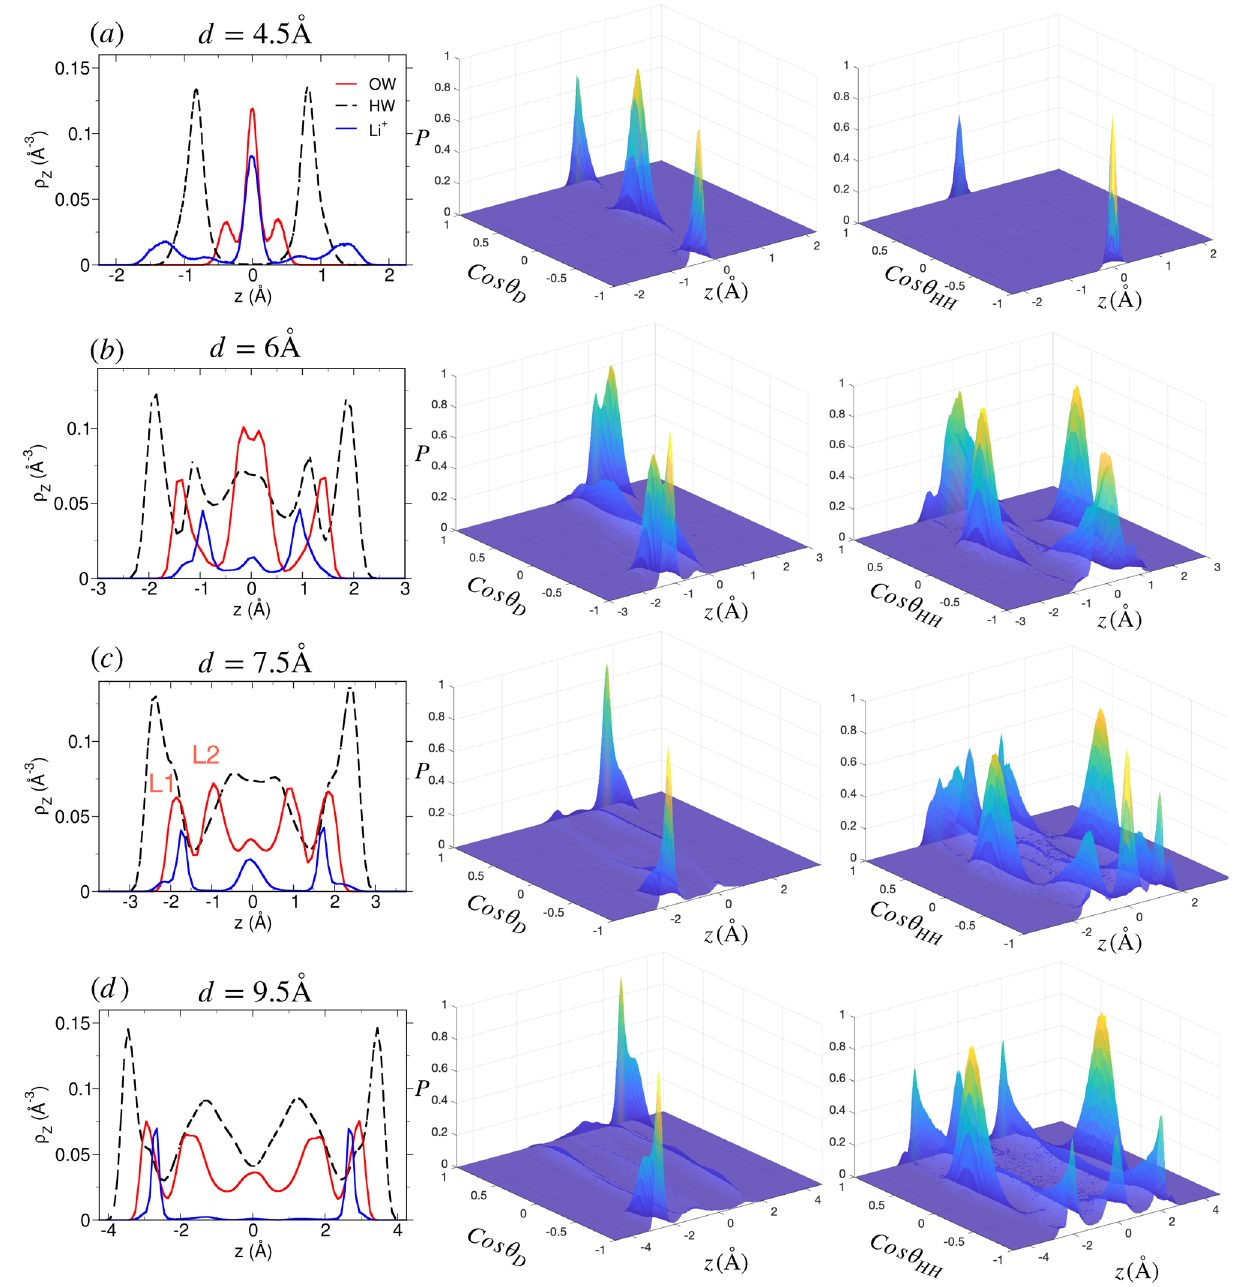
Figure 6. Structure of confined water and Li + ion at various d in Li-mica system. Legends are same as explained in Fig. 5. Note the difference in density of Li + ions and Na + ions of Fig. simple fluids confined between planar surfaces 83–89 the periodic oscillation in �( d ) and hence (cid:31)(cid:30) ex arises due to sequential change in number of fluid layers. The maxima in �( d ) corresponds to compact and dense arrange- ment of ‘ n ’ fluid layers and subsequent minima in �( d ) with both increase or decrease in d leads to formation of diffuse layers of fluids inside pores. Similar behaviour is observed here also, however due to hydrogen bonding capacity of water and hydration of ions these oscillations are not observed at integer multiple of size of the water molecules. The pore widths at which (cid:31) = 0 are the configurations where the mica framework are in equilibrium with the confined fluid (reported in Table S2 of SI). For example, these configurations in Na-mica system are found to be at d = 5.9 ( ≈ 6 ) , 6.95 ( ≈ 7 ) , 7.5, 7.91 ( ≈ 8 ) , 8.5, 11.5, and ≥ 13.5 Å. At larger pore widths, the two confining surfaces are separated by a pool of bulk-fluid and interfacial effect of surface do not affect, hence (cid:31) = 0 . Further, the fluctuations in (cid:31) for d > 11 Å is minimal; hence can be assumed to be zero. Among these configurations (where Π = 0), the pore widths which occur at the (i) repulsive branch of (cid:31) (i.e., d �/ d d < 0 ) and (ii) attractive branch of (cid:31) are the stable and unstable configurations, respectively. These are better illustrated